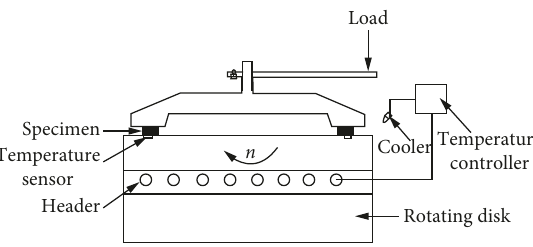
Figure 4: Schematic of the friction-wear mode [28].